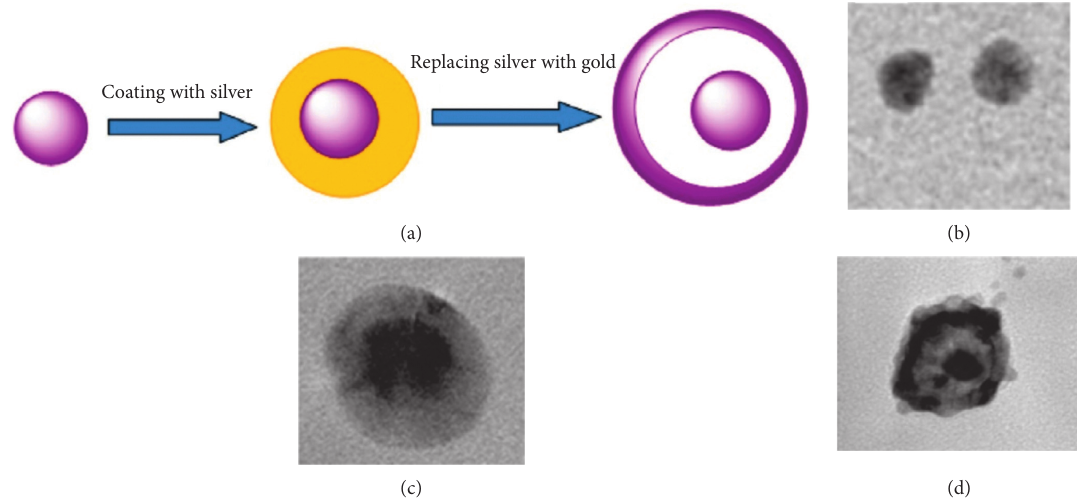
Figure 5: Schematic of the synthesis of hollow gold nanospheres during galvanic substitution with associated transmission electron microscope images [29].